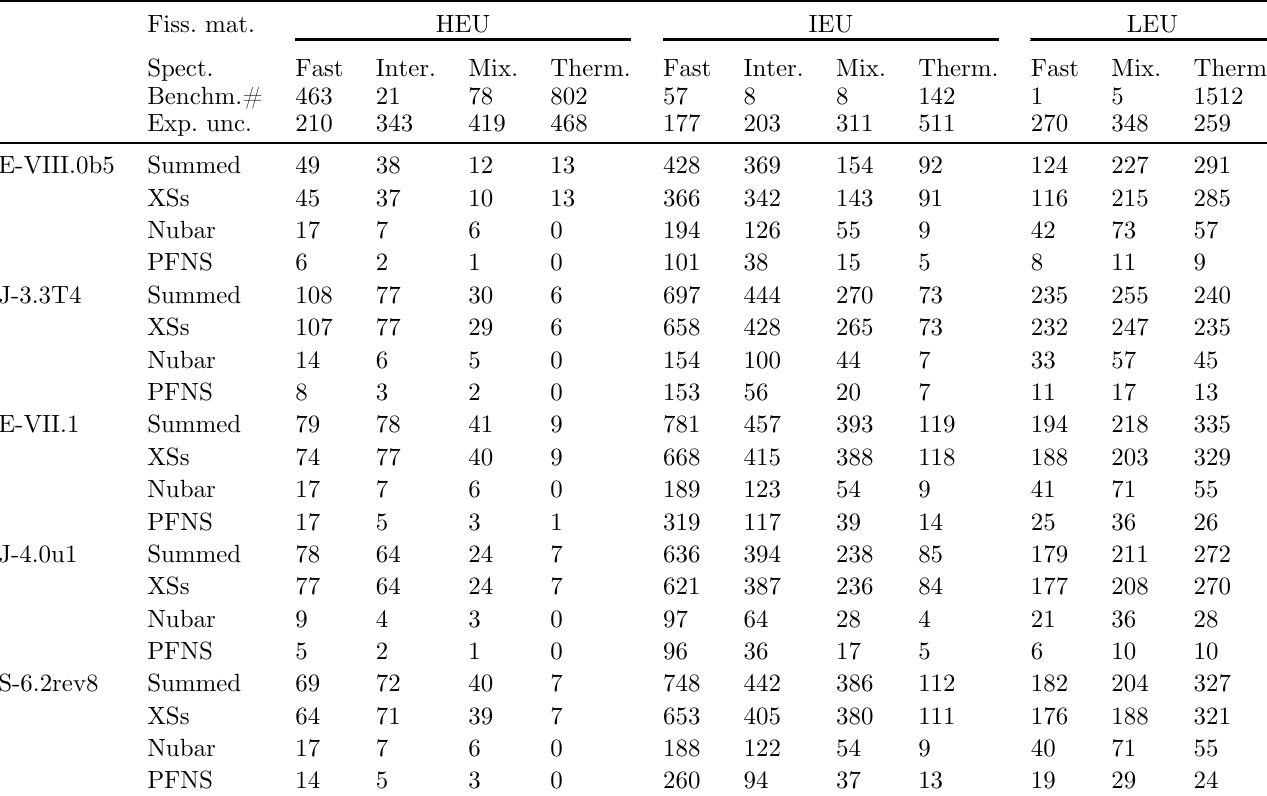
Table 2. Impact of different 238 U nuclear data covariances in ICSBEP suite averaged for fi ssile material and spectrum. Fiss. mat. HEU IEU LEU Spect. Fast Inter. Mix. Therm. Fast Inter. Mix. Therm. Fast Mix. Therm. Benchm.# Exp. unc. 210 343 419 468 177